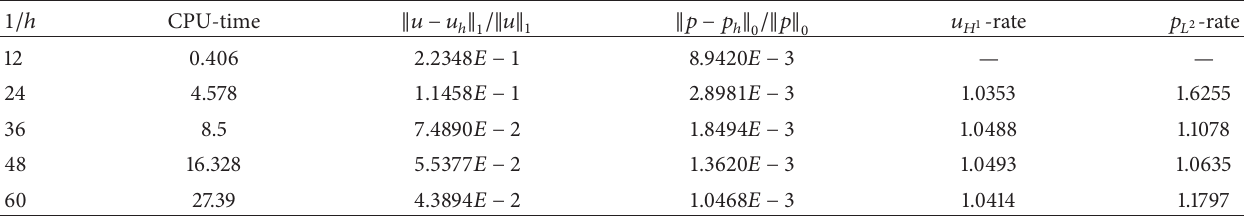
Table 4: Results got from the local Gauss integration method with ] = 1.0𝑒 − 4 , 𝛼 = 1.0𝑒 − 4 , and 𝑟 = 3 .